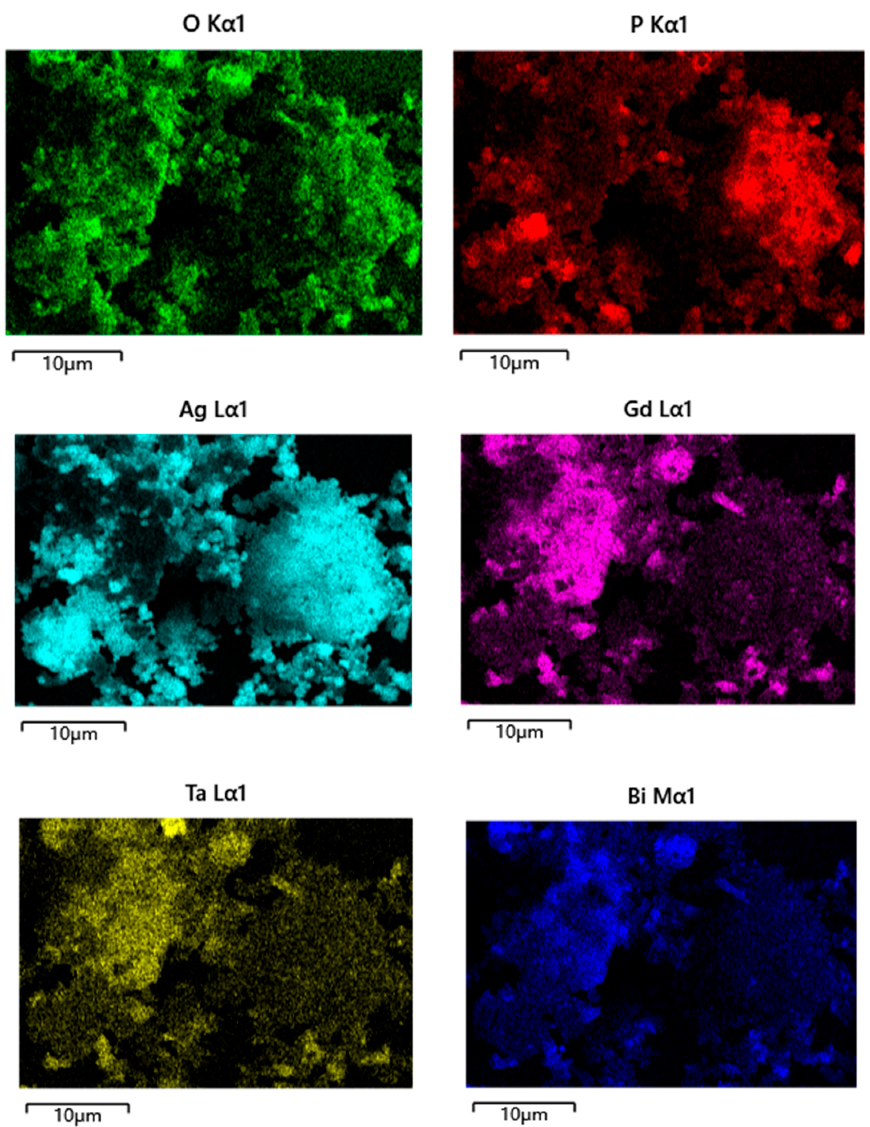
Figure 25. EDS spectrum of Ag 3 PO 4 /Gd 2 BiTaO 7 heterojunction photocatalyst.